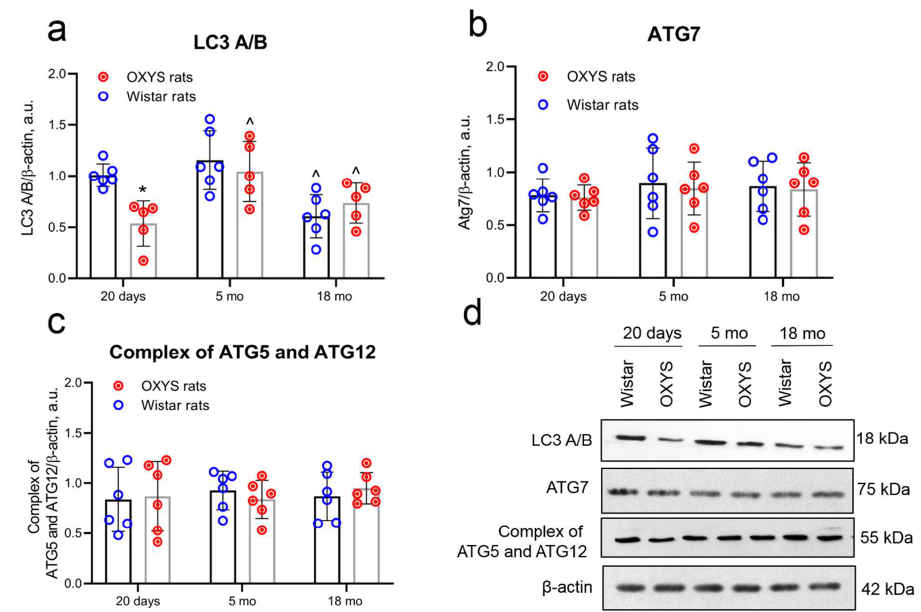
Figure 2. Alteration of autophagy proteins during aging and development of Alzheimer’s disease-like pathology. Protein expression of LC3 A/B ( a ), ATG7 ( b ), and of the ATG5–ATG12 conjugate complex ( c ) in the cortex from normal Wistar rats and from OXYS rats with Alzheimer’s disease (AD)-like pathology. ( d ) Representative immunoblots of LC3 A/B, ATG7, and of the ATG5–ATG12 conjugate complex in the cerebral cortex of OXYS and Wistar rats. Data are presented as mean ± SD, n = 5–6. * Interstrain differences, ^ age-associated differences; p < 0.05. We measured LC3 A/B levels by western blotting and immunohistochemistry in the cortex from 20-day-old and five- and 18-month-old OXYS and Wistar rats. The LC3 A/B amount in the cortex of 20-day-old OXYS rats was lower compared to Wistar rats, as was shown by western blotting ( p < 0.05). At the age of five months, the expression of LC3 A/B increased in OXYS rats ( p < 0.05), while in Wistar rats, it did not change with age. No difference was noted between OXYS and Wistar rats at this age. The LC3 A/B levels in 18-month-old OXYS and Wistar rats ( p < 0.05) were decreased compared to the age of five months (Figure 2a,d).